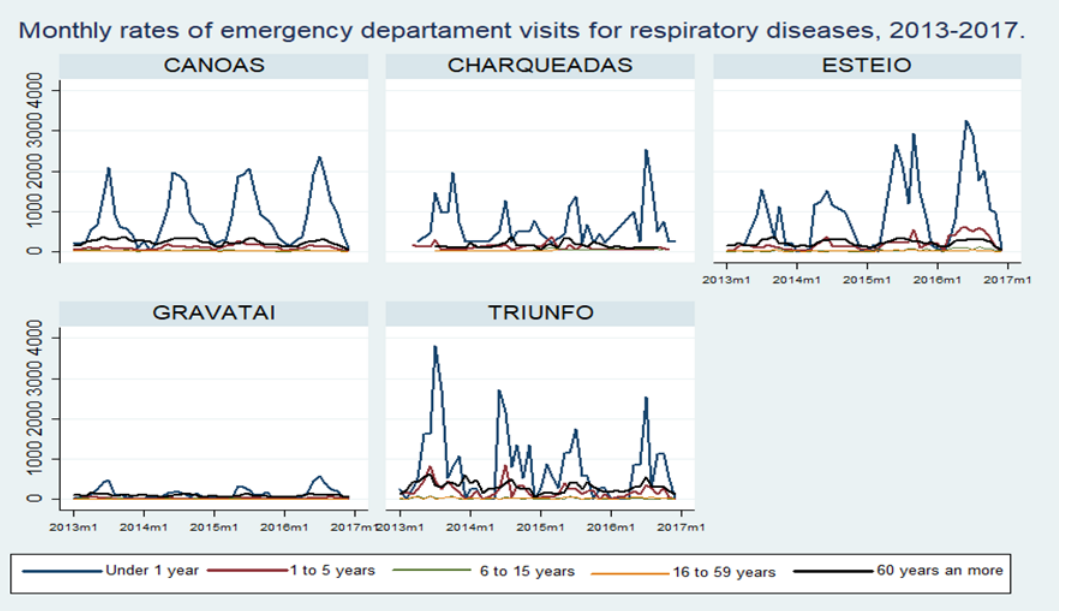
Figure 1. Monthly rates of hospitalizations per 100,000 inhabitants by municipality and age group, Rio Grande do Sul State, Brazil 2013 – 2016.